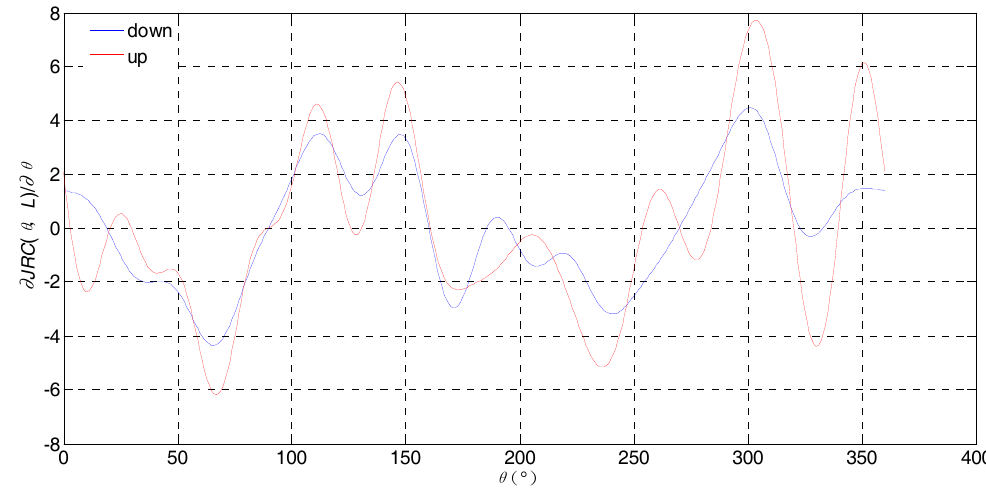
Figure 8. The changing rates of the anisotropy.